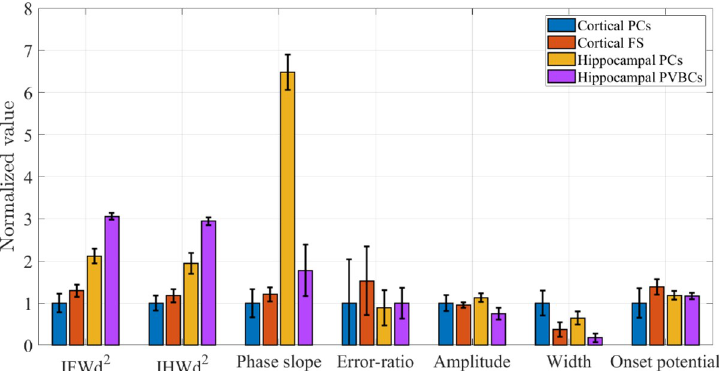
Fig 5. Comparison of the electrophysiological properties of all the neurons analyzed in this study. The vertical axis represents the values normalized to the mean value for cortical pyramidal neurons, and the error bar represents the RSD for each neuron population. The phase slope value for hippocampal pyrmidal cells is obtained using pchip interpolation, and the error ratio value for PVBCs are obtained with the upper limit was set to 3 mV above the onset.